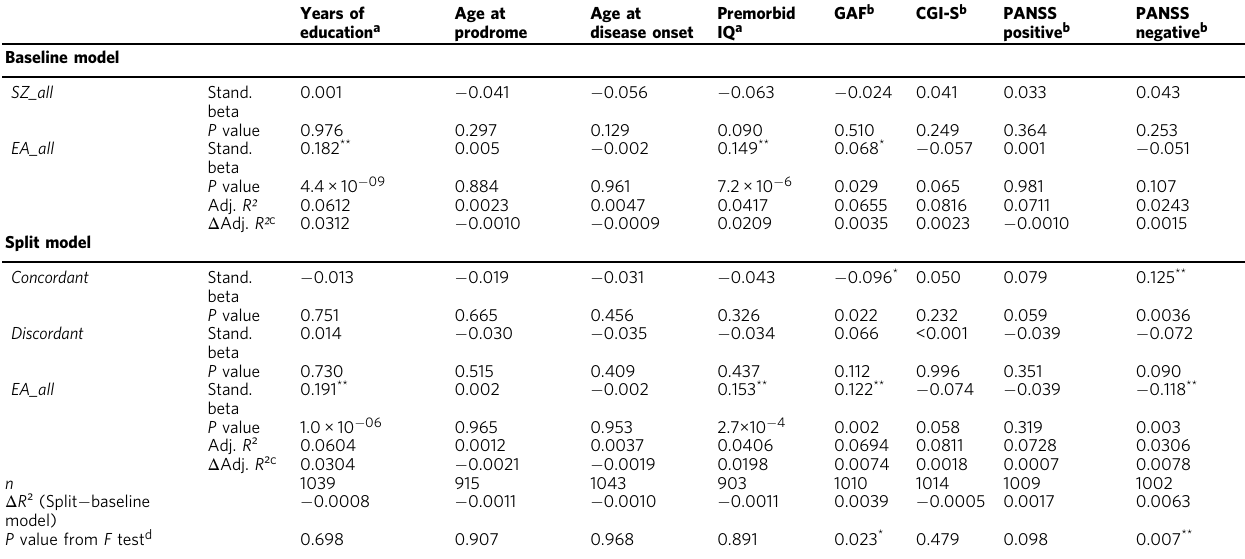
Table 2 Polygenic prediction of schizophrenia measures in the GRAS patient